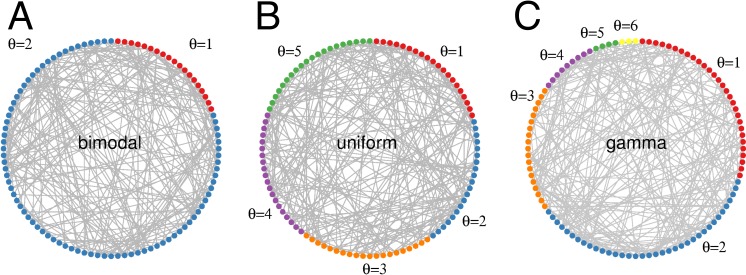
Threshold distributions in random networks.Threshold θ indicates the minimal number of coincident excitatory contributions required to excite a quiescent unit. (A) Bimodal distribution with 80% integrators (θ = 2). (B) Uniform distribution with \documentclass[12pt]{minimal}
\usepackage{amsmath}
\usepackage{wasysym}
\usepackage{amsfonts}
\usepackage{amssymb}
\usepackage{amsbsy}
\usepackage{upgreek}
\usepackage{mathrsfs}
\setlength{\oddsidemargin}{-69pt}
\begin{document}
}{}${\theta }_{\mathrm{max}}=5$\end{document}θmax=5. (C) Gamma distribution with shape parameter a = 2, and scale parameter b = 1.